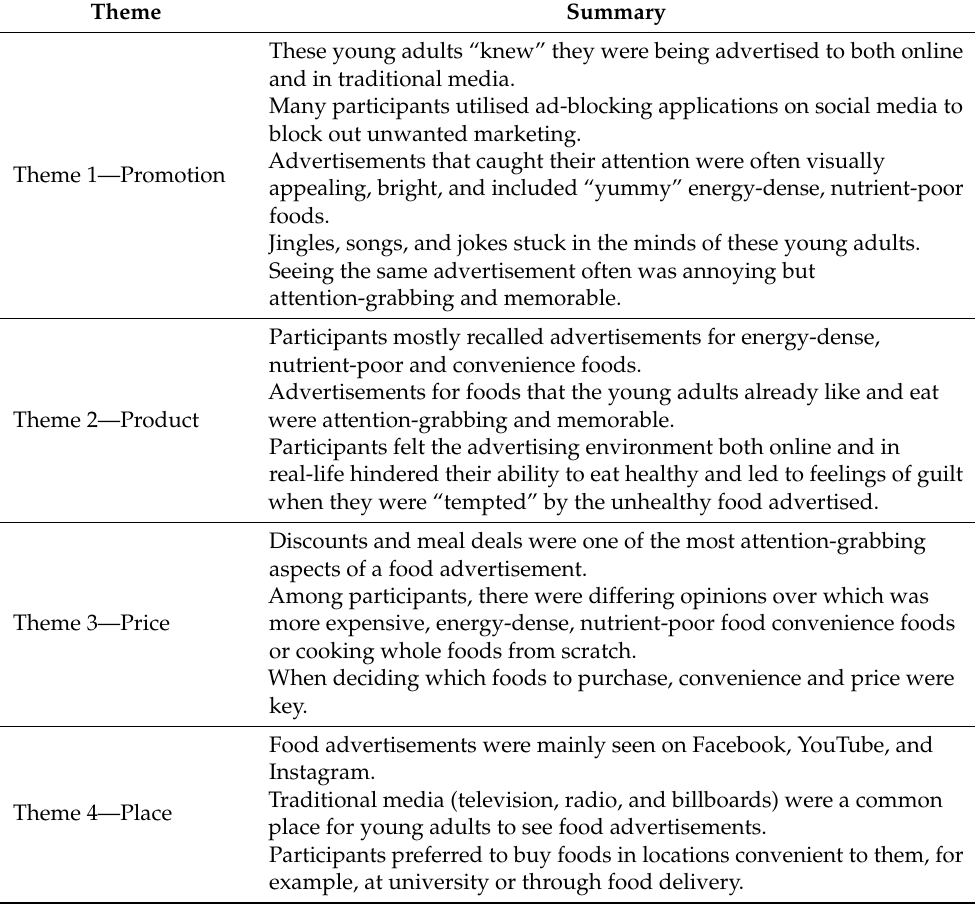
Table 3. Summary of thematic analysis.